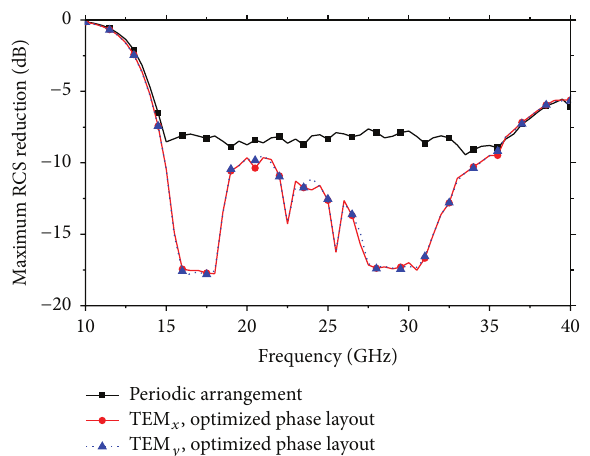
Figure11:SimulatedmaximumRCSreductionforperiodicarrange- ment and optimized phase